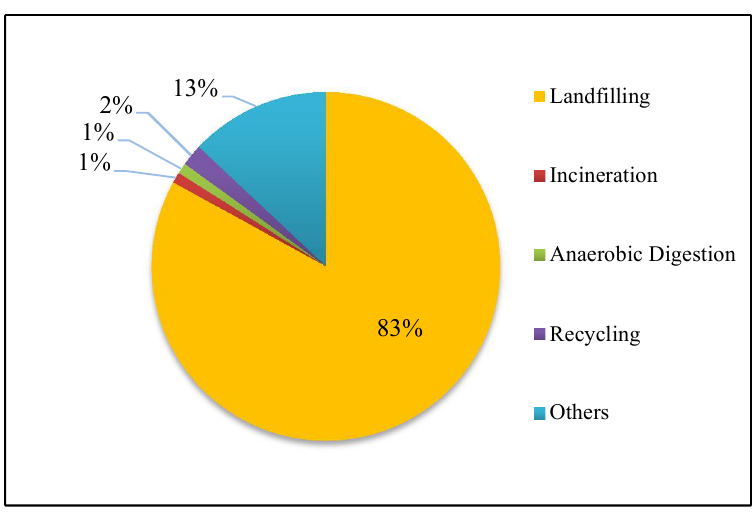
Figure 4. Comparison of waste disposal methods by percentage of daily treated municipal solid waste ( MSW) by weight in Myanmar [7,31].